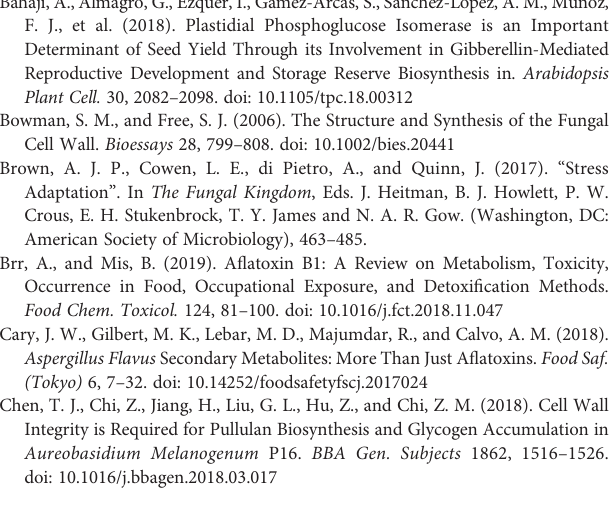
Supplementary Figure 2 | Construction and con fi rmation of the D pgi mutant and revertant (RT) strains. A, strategies to generate the D pgi and RT strains by homologous recombination. B, genomic DNA was digested by Hind III/ Sma I and hybridized with probe 1 (1.0 kb) to detect the upstream region of the pgi gene or probe 2 (1.0 kb) to detect the AfpyrG gene. C, PCR analysis of the D pgi mutant and RT strains using four pairs of primers described under materials and methods. Supplementary Figure 3 | Growth of the D pgi mutant on medium containing different carbon sources. 10 2 -10 5 conidia of the WT, D pgi and RT strains were inoculated onto the medium containing 1% of Gluconate, N-acetylglucosamine (GlcNAc), galactose (Gal) or glycerol (Gly) as the sole carbon source and cultivated at 37°C for 48 h. Supplementary Figure 4 | Germination of the D pgi mutant. A, differential interference contrast microscope (Leica) was used to observe the germination of the strains at speci fi ed time; B, germination rate was calculated based on observing around 100 conidia per strain. Numbers in this table indicate spores that have germinated. The experiment was repeated three times. Scale bar: 10 mm. The data were presented as mean ± SD . Supplementary Figure 5 | Sensitivity of the Dpgi mutant to chemical compounds. Gradient dilution of 10 2 -10 5 conidia of the WT, D pgi and RT strains were cultivated on MMFG supplemented with 100 mg/ml CFW, 50 mg/ml SDS, 2 mg/ml CAS, or 1 mg/ml AMB at 37°C for 48 h. Supplementary Figure 6 | Growth of A. fl avus strains on peanut powder or corn powder plates. Ground powder of peanuts or corn was mixed with 1.5% agar to make 1%,3% and 5%plates. 5 mlof 10 8 conidiaof differentstrains wereinoculated into the center of the plates, then incubated at 37 for 4.5 days. Supplementary Table 1 | Primers used in this study. Supplementary Table 2 | Survival rate, hyphal fi lamentation and worm numbers of glp-4(bn2); sek-1(km4) infected by the WT, D pgi and RT strains. The survival rate and hyphal fi lamentation rate were calculated with glp-4(bn2); sek-1(km4) worms after pre-infected with conidia for 16 h. E. coli OP50 was used as a positive control. Six biological repeats (each with triplicates) were conducted and total counted worm numbers are indicated. Supplementary Table 3 | Survival rate of G. mellonella larvae infected by the